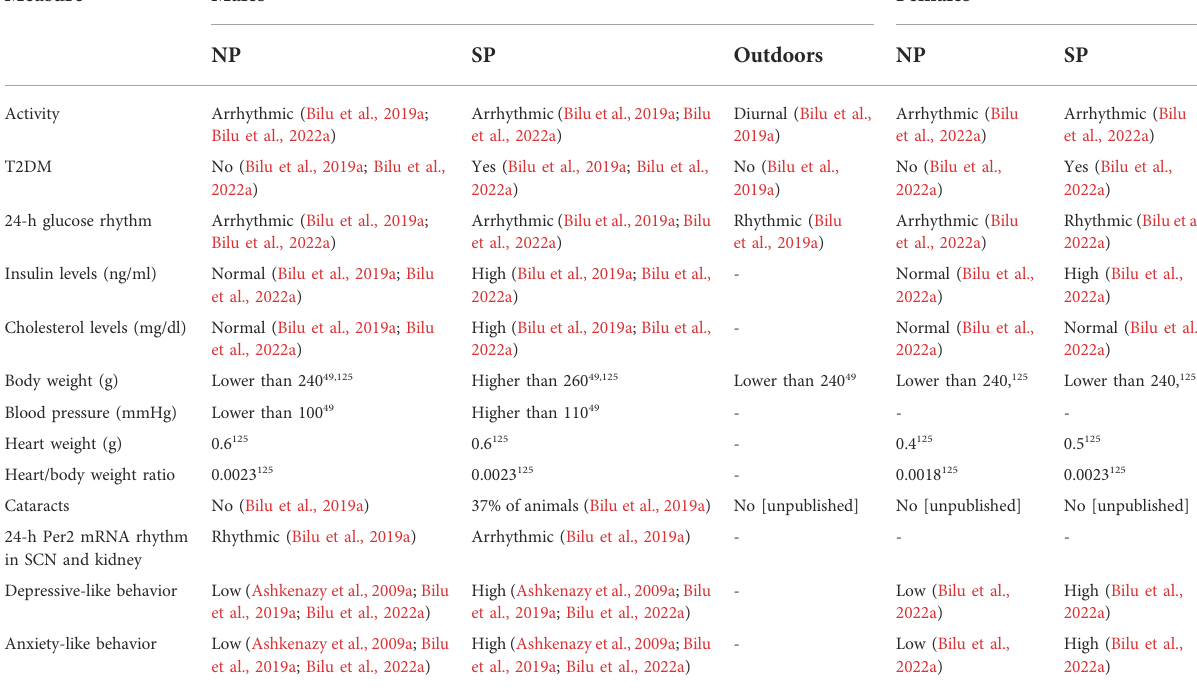
TABLE 2 Comparison of physiological and behavioral measures of male and female fat sand rats under SP or NP.